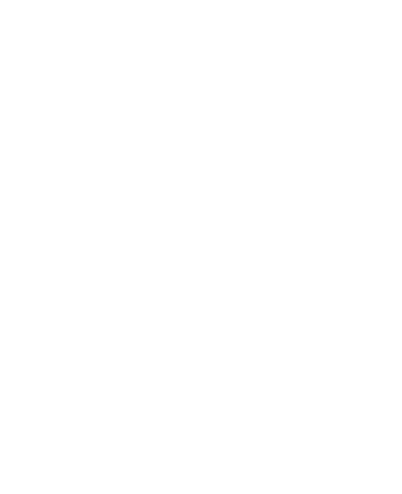
Table 4. Sphincter function changes following the intervention.